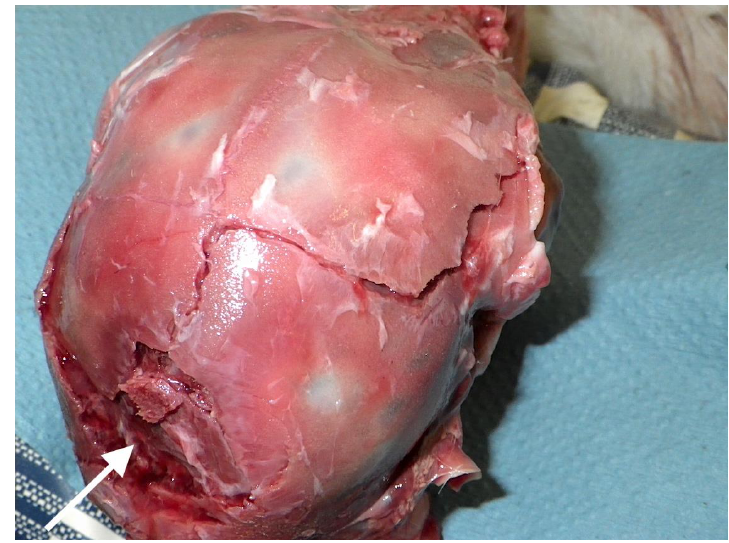
Figure 11. Extension of fracture lines following sk Bock Lane, Philipsburg, PA 16ull sutures Kid 116 Figure 11 Extension of fracture lines following skull sutures Kid 116 (caudal shot position indicated (caudal shot position indicated by arrow). by arrow).